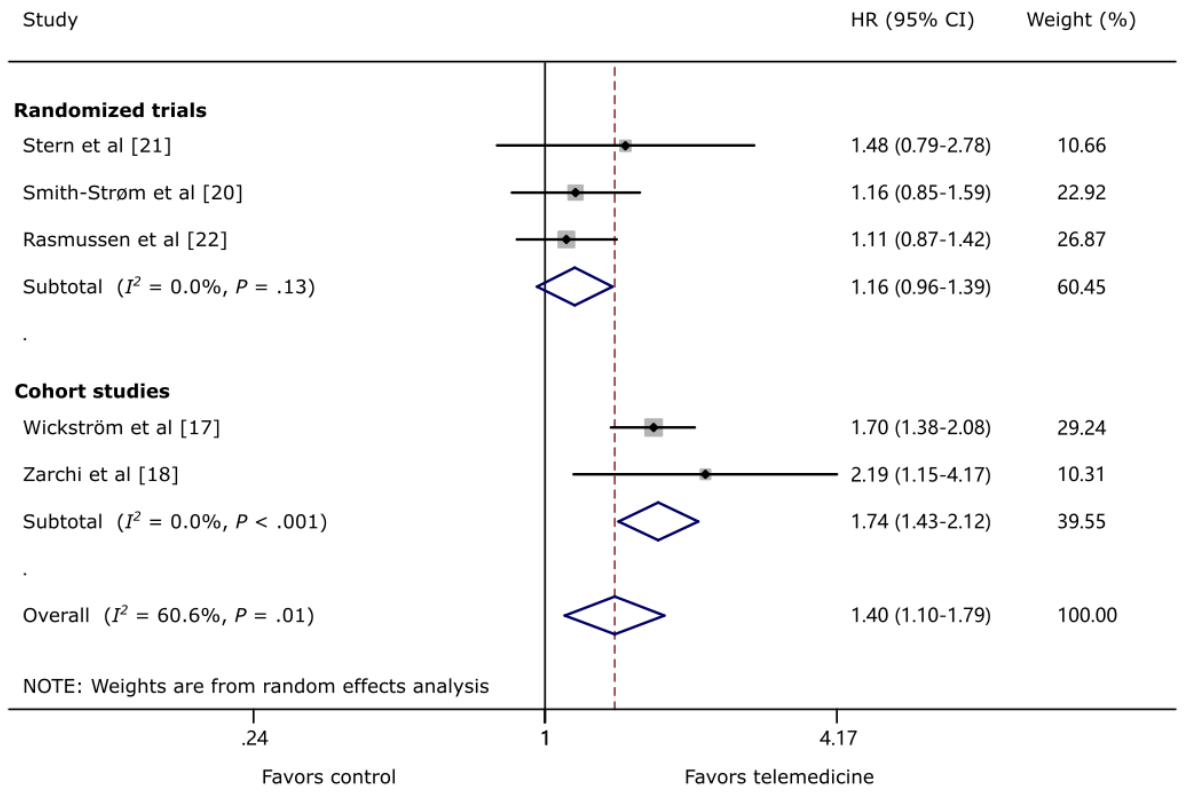
Figure 1. The effect of telemedicine on wound healing. HR: hazard